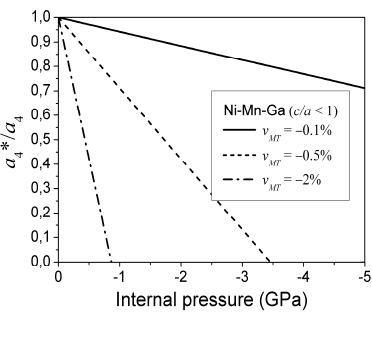
Figure 11. The influence of internal pressure on the coefficient of the third-order energy term, which predetermines the first-order character of martensitic transformation in the Ni-Mn-Ga alloy considered in